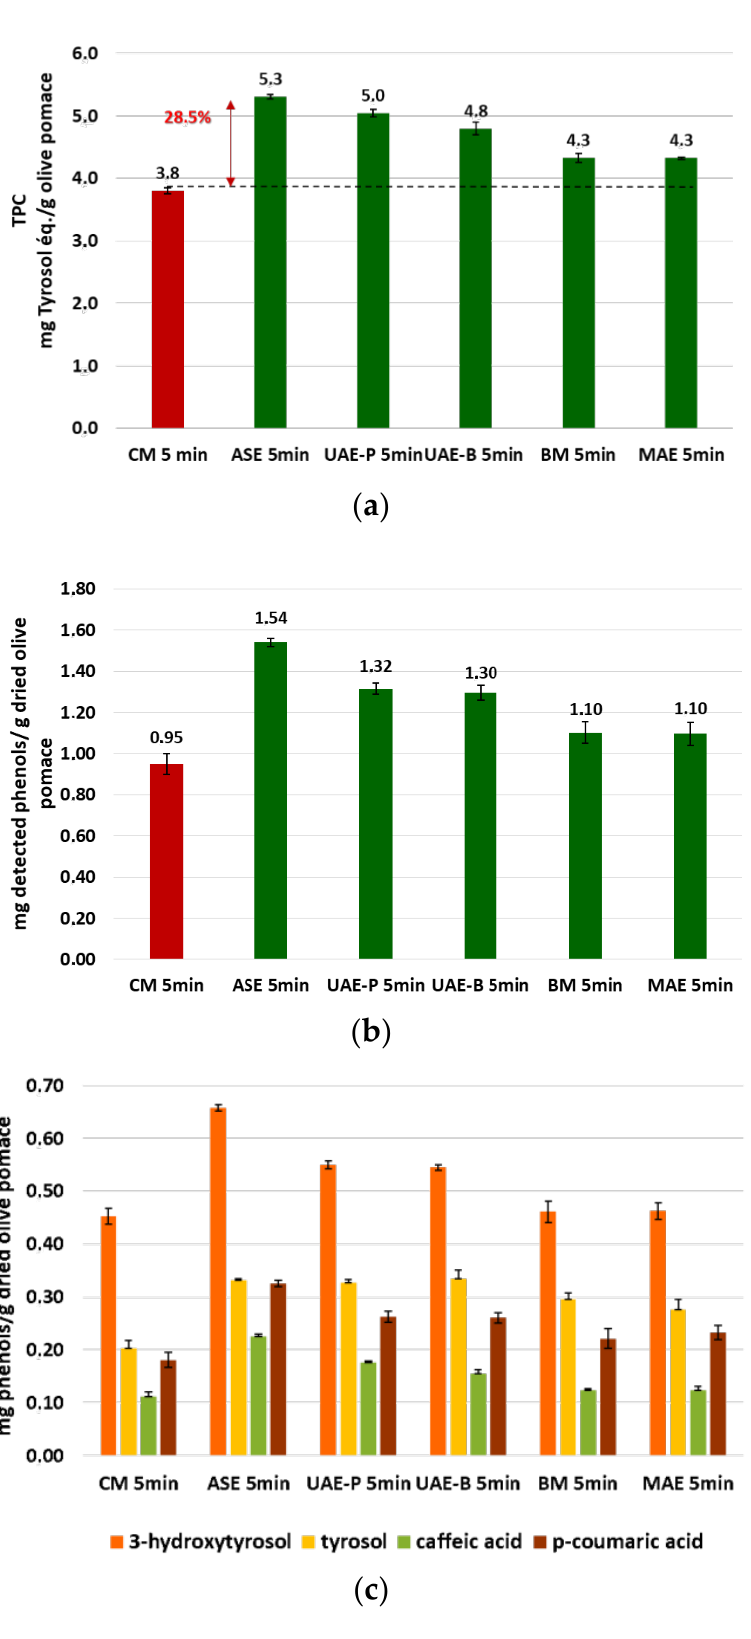
Figure 8. Comparison of the green extraction techniques by TPC determination ( a ), sum of quantified phenols by UPLC ( b ), and quantified phenols by UPLC ( c ).